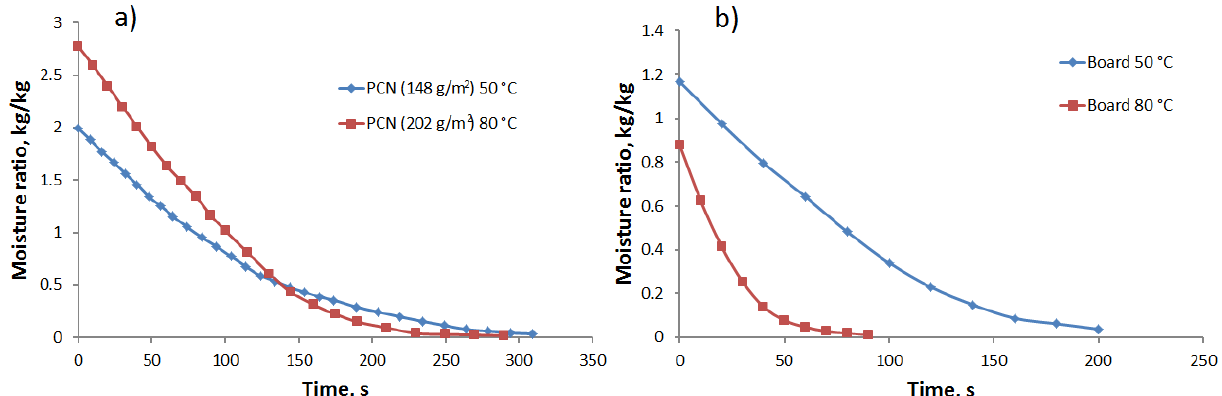
Figure 2. Drying kinetics for the contact drying of ( a ) PCN and ( b ) board sheets at two different temperatures: 50 °C (blue) and 80 °C